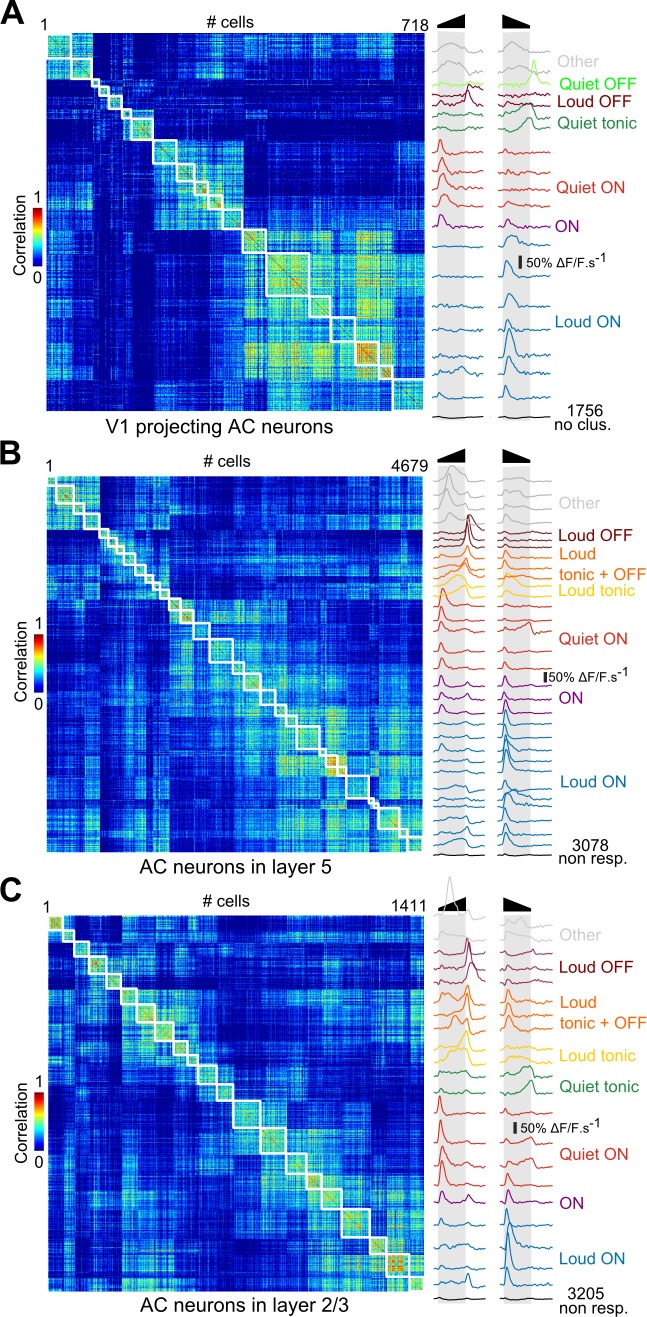
Correlation matrices for all clustered neurons.Matrix of sound response correlation for all cells that could be assigned to a cluster, (A) for auditory cortex neurons that project to V1 (same as Figure 1C), (B) for auditory cortex neurons in upper layer 5 (370 to 430 µm depth), (C) for auditory cortex neurons in layer 2/3 (150 to 250 µm depth). The average response trace of each cluster (mean deconvolved calcium signal across cells) is shown on the right with a color code corresponding to the functional label given to the cluster. The bottom trace (black) shows the average response for the cells that were not assigned to a cluster (non- or weakly-responsive cells).